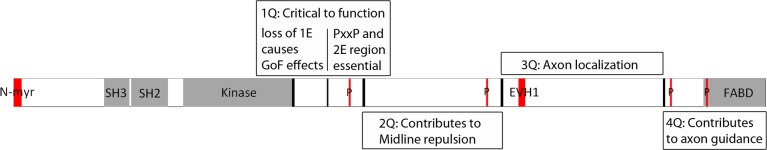
Summary schematic highlighting the role of each region of the CTD.A linear model of Abl is depicted with each quarter of the CTD delineated. The accompanying text boxes provide short statements highlighting the role that each region is thought to contribute to Abl function, as determined in our analysis. See text for details. GoF: gain-of-function.